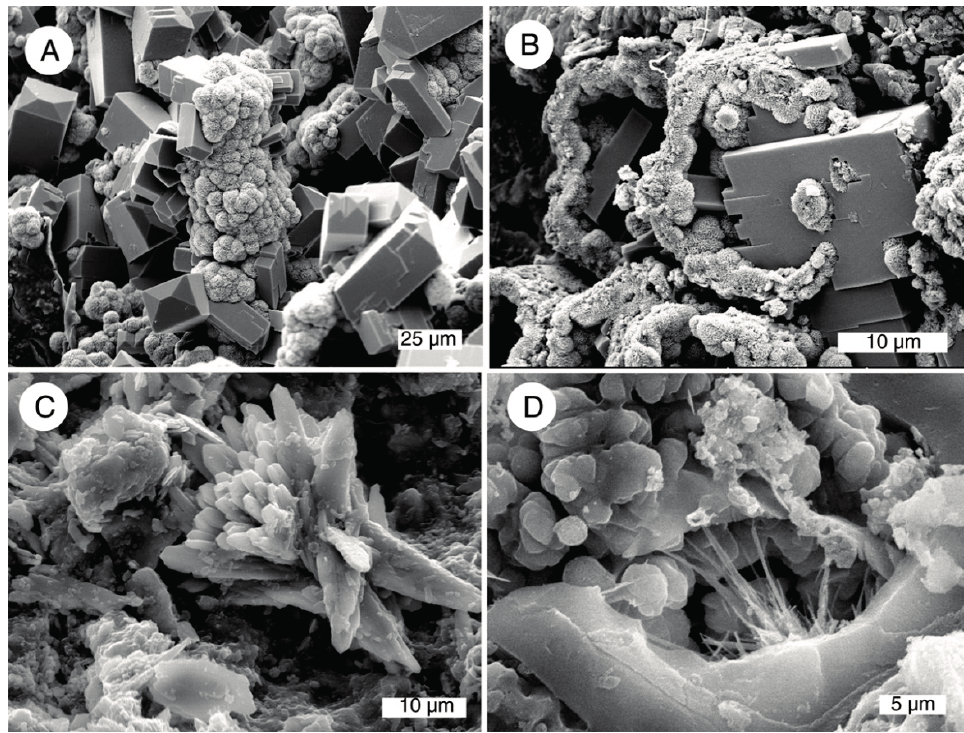
Figure 16. Non-silica mineral inclusions in silicified wood. ( A ) Oblique transverse view showing tracheids encrusted with botryoidal opal-CT, intergown with blocky zeolite crystals derived from alteration of the tuffaceous matrix, locality 2 (Rainbow Ridge opal mine); ( B ) Transverse view showing cell walls mineralized with opal-CT, intergrown with zeolite crystals, locality 2 (Royal Peacock opal mine); ( C ) Radiating barite crystals on chalcedony mineralized wood, locality 11; ( D ) Acicular gypsum microcrystals in opal-CT wood, locality 20. Non-silica minerals were identified from SEM/EDS